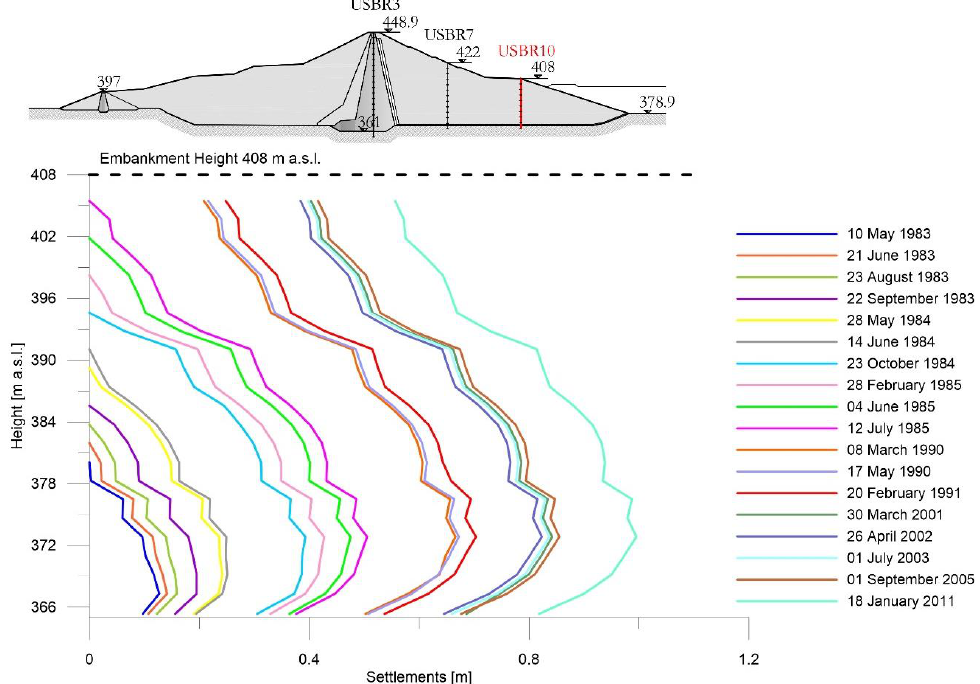
Figure 11. Extensometer USBR 10: settlement profiles observed during construction and working phases.